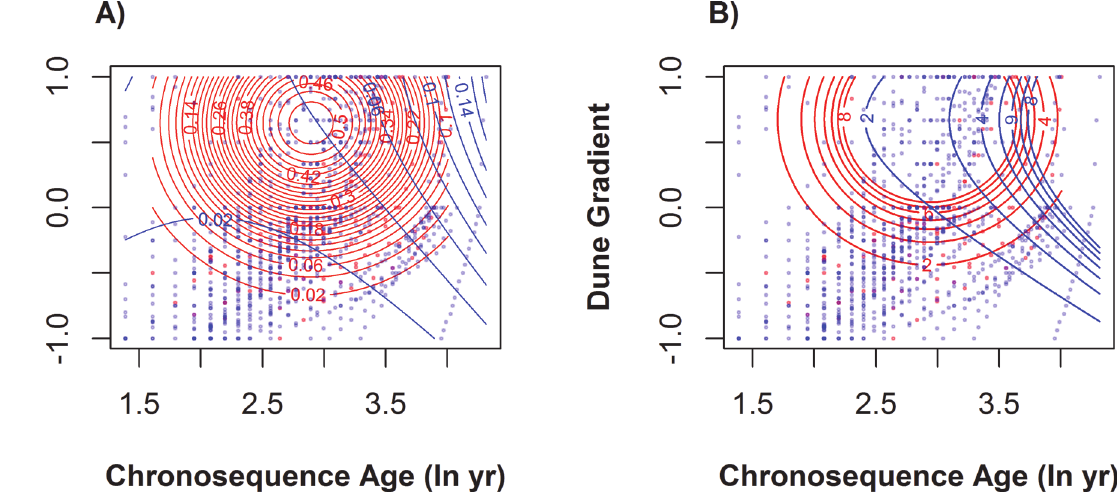
Fig 3. Contour plot of (A) native cover and (B) species richness shows differences in distribution across across chronosequence ages and dune gradient in dunes of different Ammophila dominance. Contours show areas of increasing cover or richness across both gradients. Quadrats from sites dominated by A . arenaria are shown in red, those from A . breviligulata sites shown in blue. See main text and Fig. 2 caption for additional